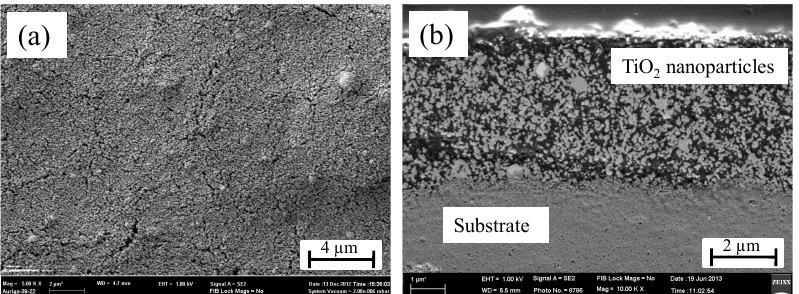
Figure 4. FESEM images of TiO nanoparticles coated on Au interdigitated alumina 2 substrate followed by heat treatment ( a ) in top view and ( b ) cross sectional view.